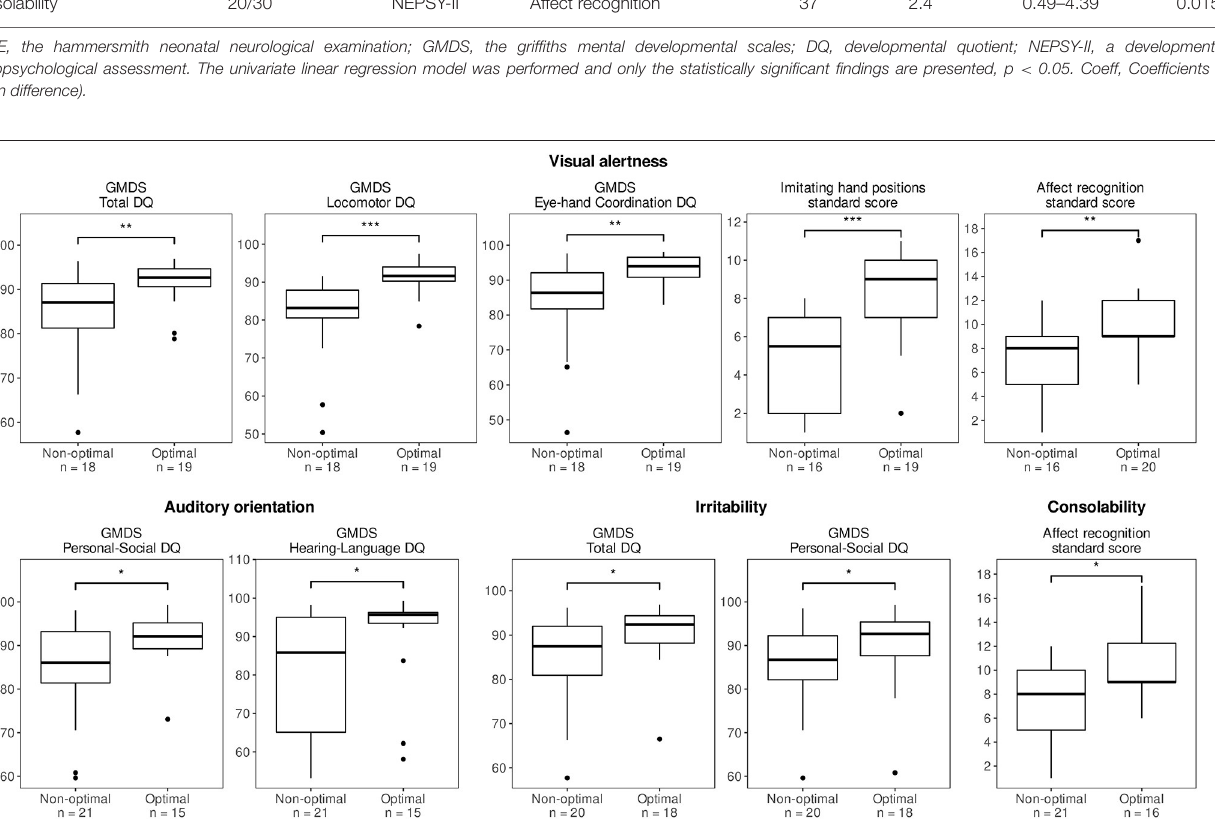
FIGURE 2 | The relationships between the performance on the Hammersmith Neonatal Neurological Examination (HNNE) items and the Griffiths Mental Developmental Scales (GMDS) and a Developmental Neuropsychological Assessment. Boxplots represent median, lower, and upper quartiles. Mann-Whitney U -test was used, and only significant findings are presented. * p < 0.05, ** p < 0.01, *** p <